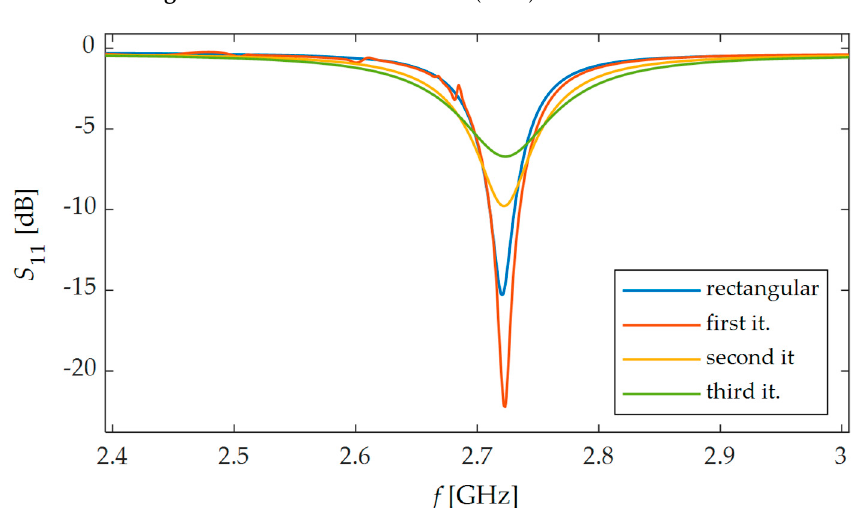
Figure 5. Calculated reflection coefficient characteristics S 11 for proposed microstrip transducers.